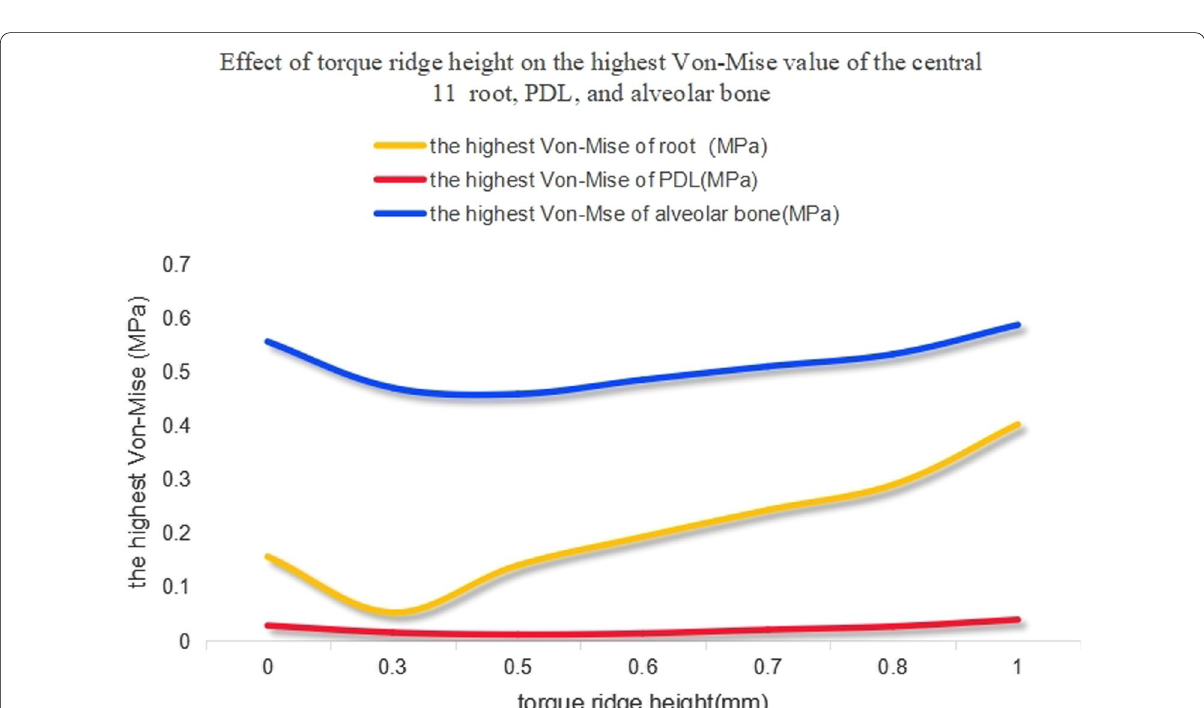
Fig. 7 The highest von-Mises value of the central incisor root, PDL, and alveolar bone with different power ridge heights when U1-SN